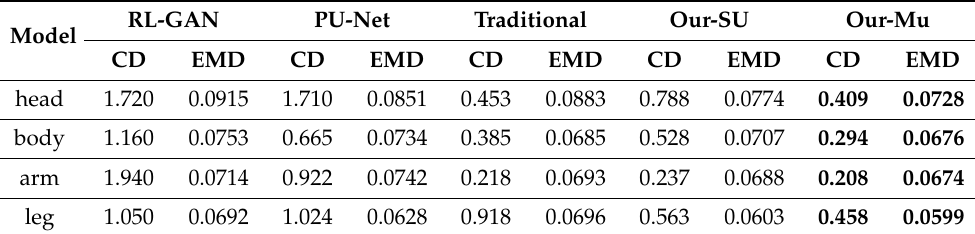
Table 1. Quantitative comparison of CD (10 − 6 ) and EMD (10 − 1 ) among our methods and several existing methods.